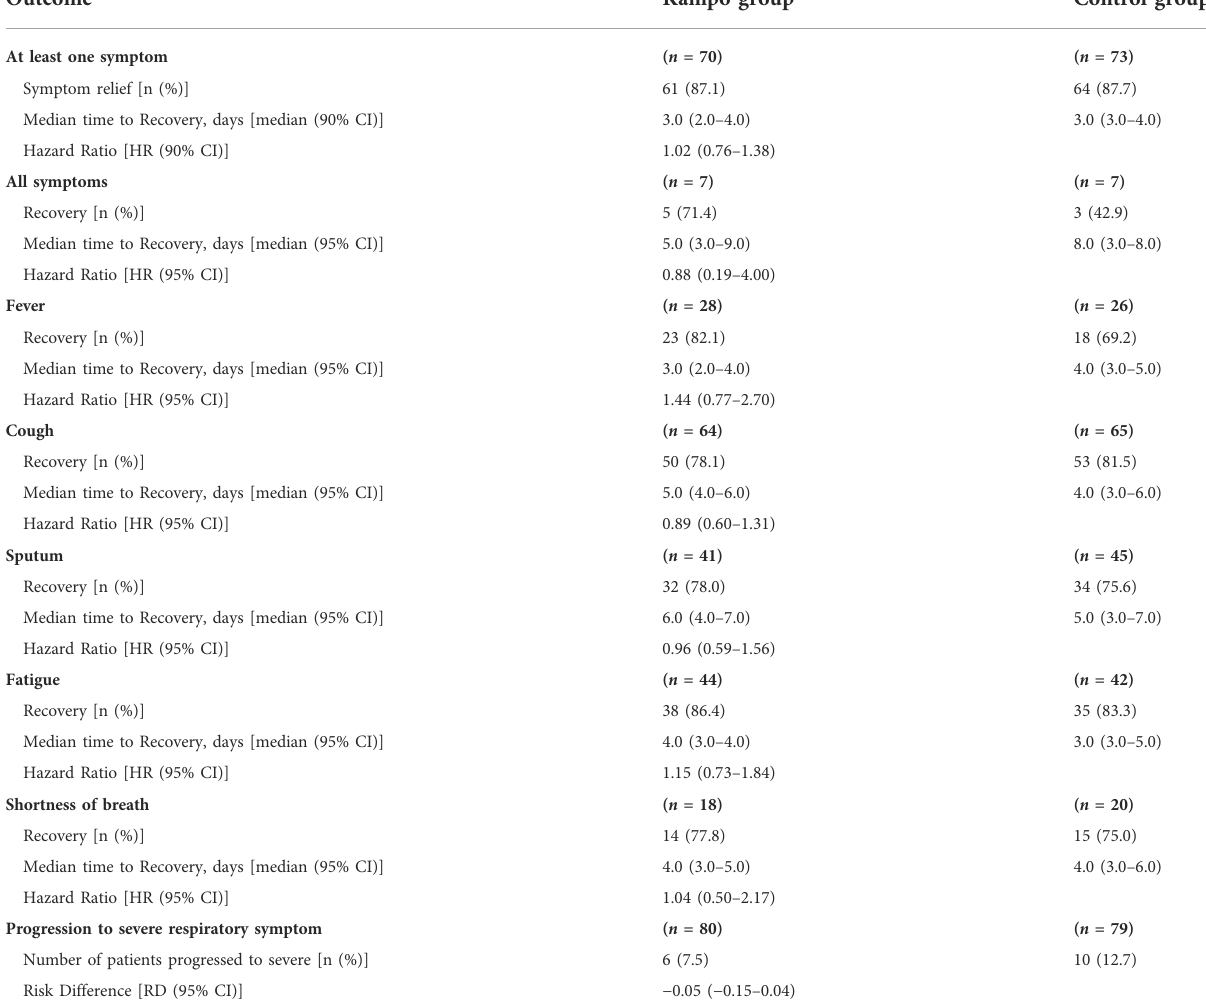
TABLE 2 Primary and Secondary